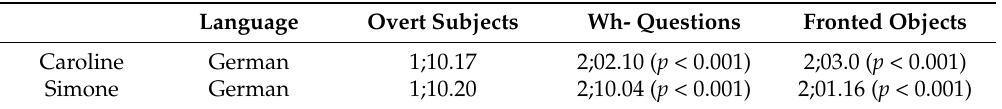
Table 3. Ages of onset and binomial test result of overt Subjects, wh- questions and fronted objects in 2 German-speakers, compiled from Grinstead and Spinner (2009, Table 6, p.